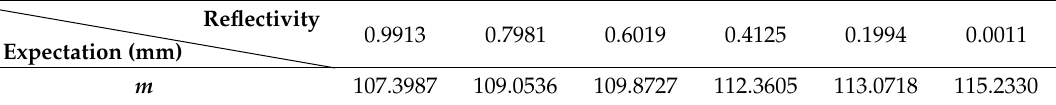
Table 6. The expectation of offset of six kinds of reflectivity at distance 1.4